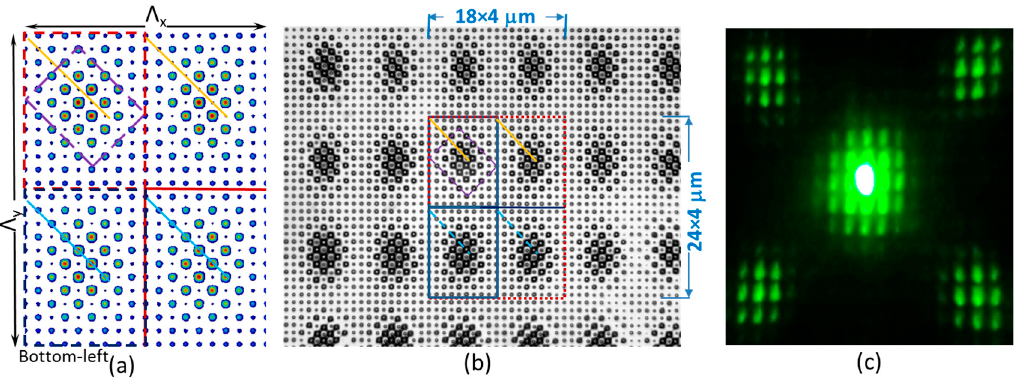
Figure 3. ( a ) Simulated eight-beam interference pattern; ( b ) the charge-coupled device (CCD, attached to an optical microscope) image of the fabricated graded photonic super-crystal in dipentaerythritol penta/hexaacrylate (DPHPA); ( c ) diffraction pattern of a fabricated sample from 532 nm laser.